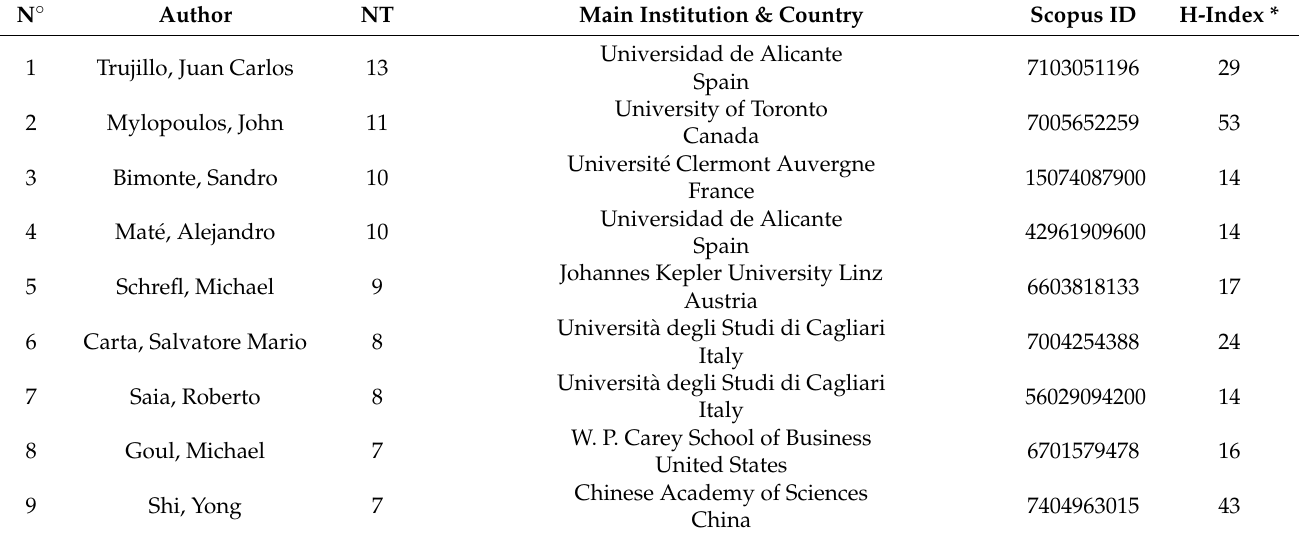
Table 5. Top 9 most productive authors by number of papers, institution, country, Scopus ID and h-index.